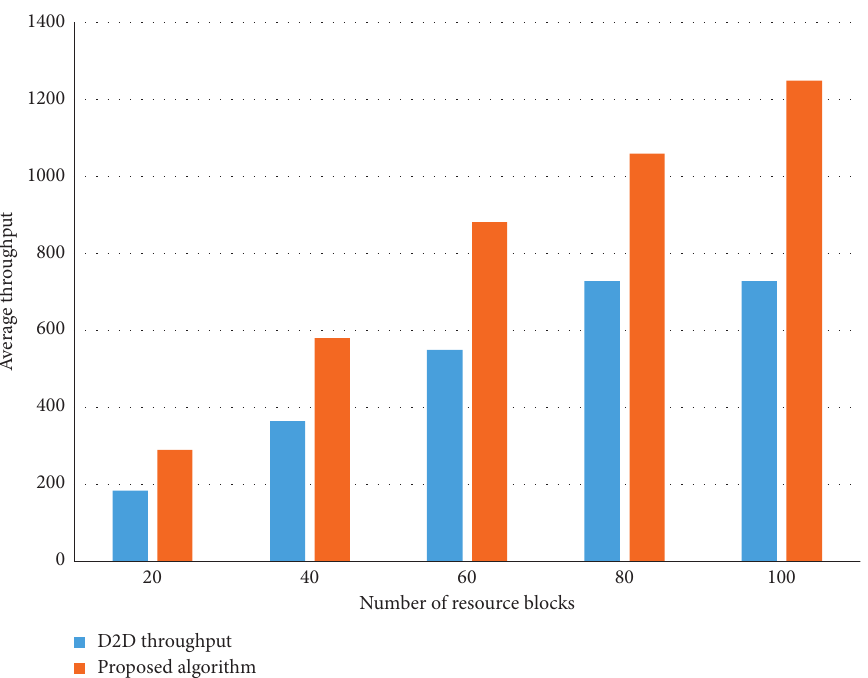
Figure 5: Average throughput against allocated no. of RBs.